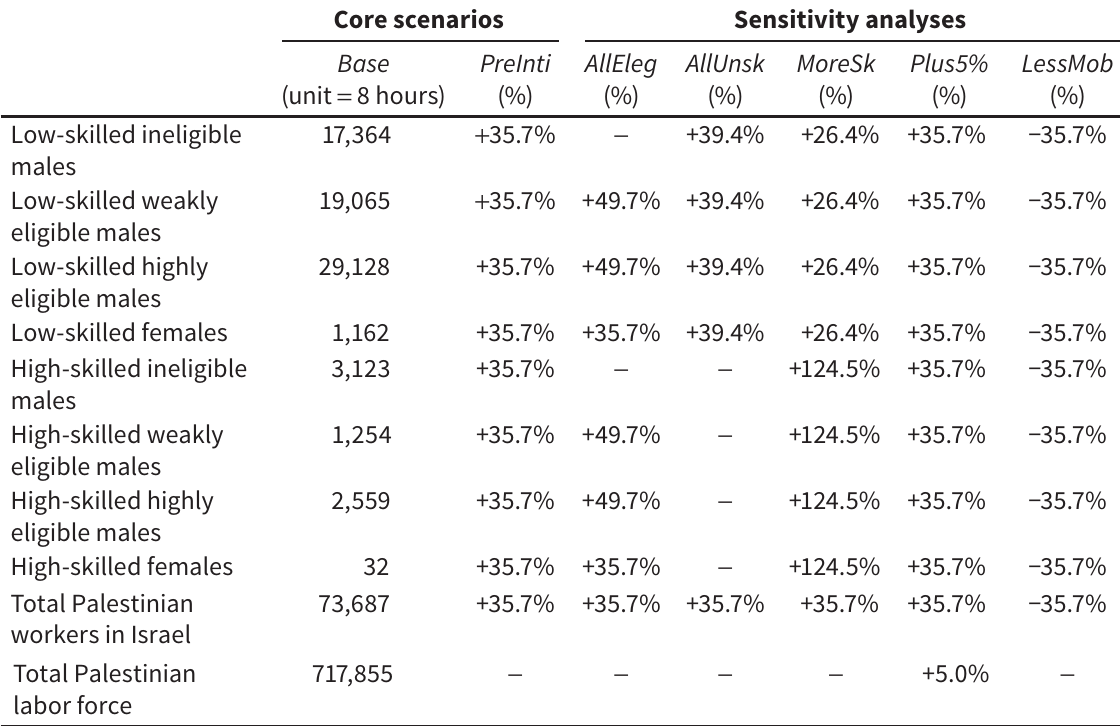
Number of Palestinian workers in Israel in the base (physical units) and in the scenarios (% change as compared to the base) Core